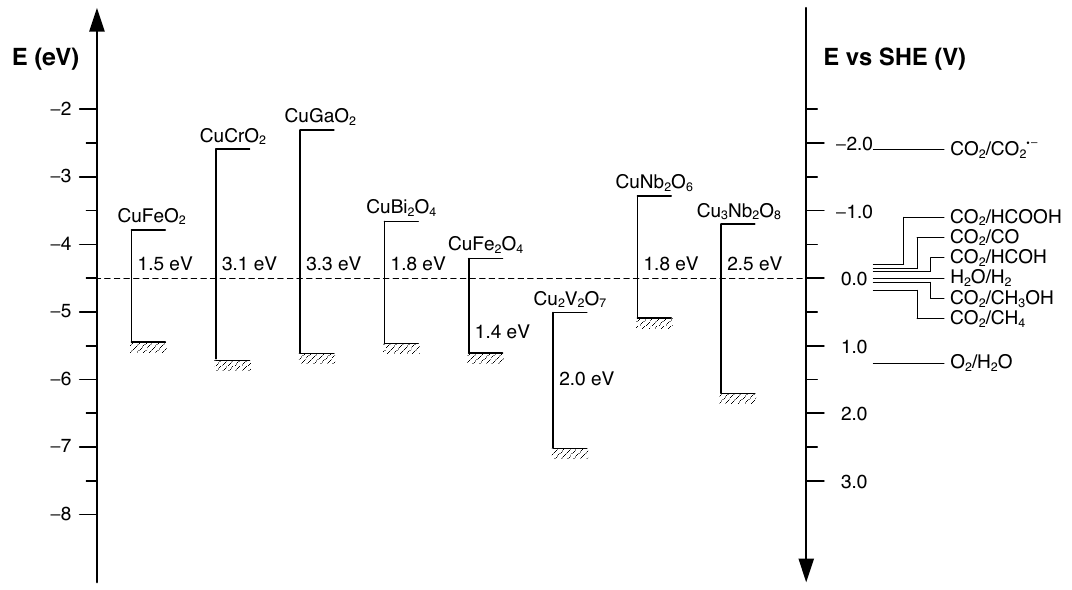
Figure 2: Conduction band and valence band position of several copper ternary oxides relative to CO 2 and water redox potentials, plotted versus vacuum ( left ) and SHE ( right ) scales. ( Adapted from ref. [ 50 ]) . Copyright © 2022, IOP